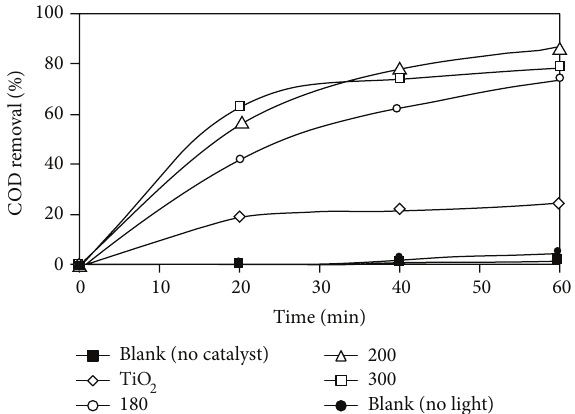
Figure 5: Photocatalytic degradation of DIPA under visible light using bimetallic Cu-Ni/TiO 2 photocatalysts (calcination tempera- tures=180,200,and300 ∘ C;DIPAconcentration=100ppm;reaction temperature = room temperature 23 ± 1; reaction volume = 100 mL; irradiation duration = 60min; light source = 500 W halogen lamp; photocatalyst loading = 1g ⋅ L −1 ).